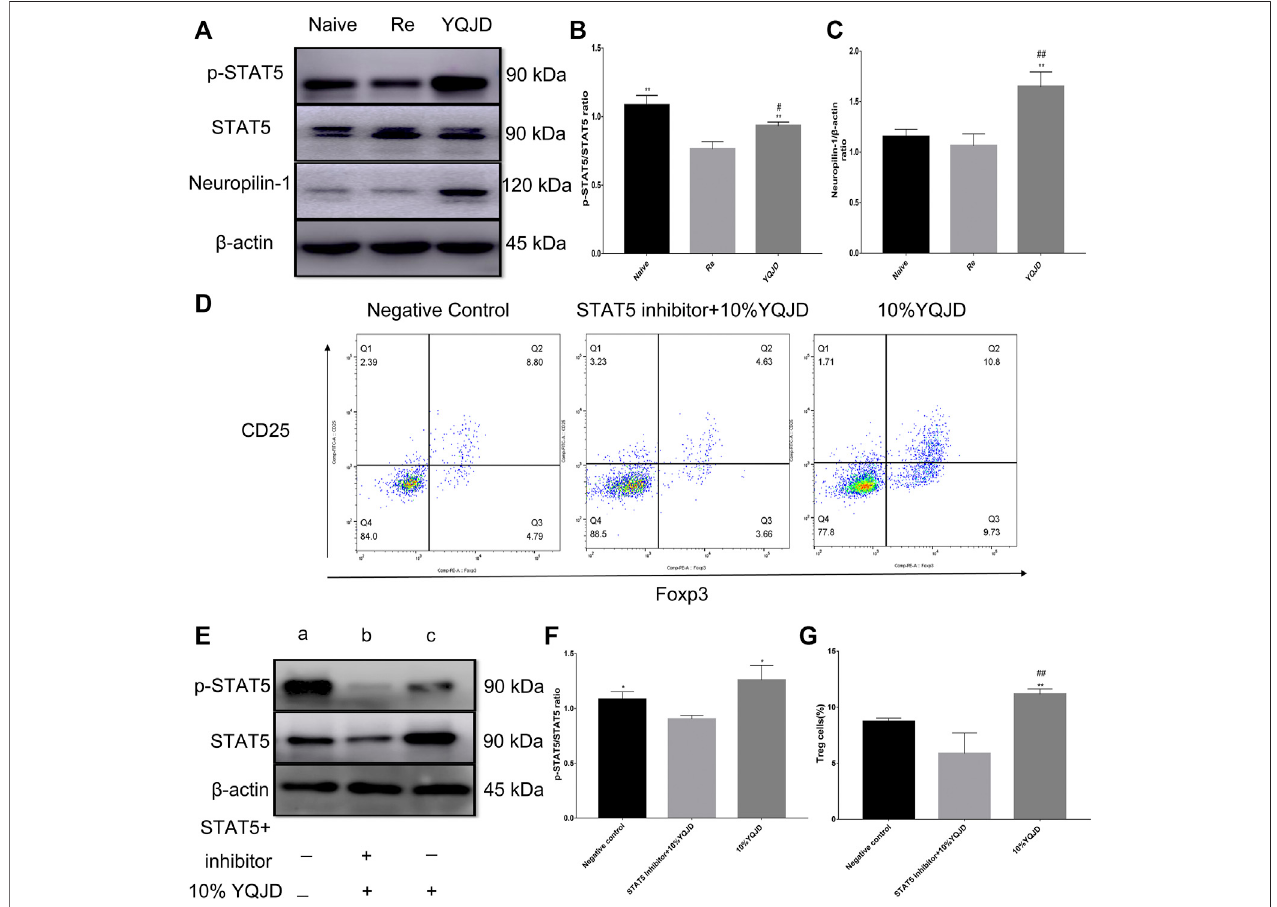
FIGURE 4 | Effects of YQJD treatment on the STAT5 signaling pathway in spleen cells of recurrent HSK mice. (A) Relative expression of p-STAT5/STAT5 and Neuropilin-1 in spleen tissues. (B,C) Statistical analysis of p-STAT5/STAT5 and Neuropilin-1 expression. (D) Expression of CD4 + CD25 + Foxp3 + Treg cells in an in vitro cultureofmousespleencells. (E) Relativeexpressionofp-STAT5/STAT5inan invitro cultureofmousespleencells. (F) Statisticalanalysisofp-STAT5/STAT5expression in an in vitro culture of mouse spleen tissue (a, NC group; b, STAT5 inhibitor +10% YQJD group; c, 10% YQJD group). (G) Statistical analysis of CD4 + CD25 + Foxp3 + Tregcell levels in an in vitro culture ofmouse spleencells. Thedata areexpressed asthe mean ± SD ofthree independent experiments. * p < 0.05 and ** p < 0.01 vs. the Re group; ## p < 0.01 vs. the Naive group; * p < 0.05 and ** p < 0.01 vs. the STAT5 inhibitor + 10% YQJD group; # p < 0.05 and ## p < 0.01 vs. the NC